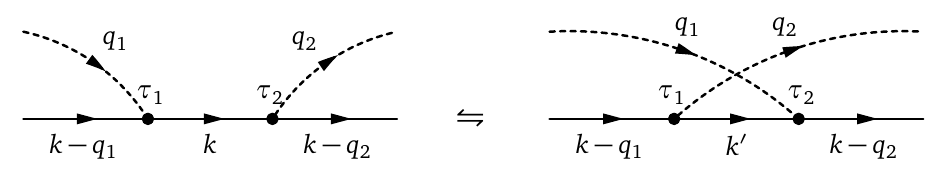
Figure 7: Illustration of the SWAP update. The phonon propagators carrying momentum q and q are understood to connect back to the fermion line at vertices at times τ 2 respectively. τ and τ may each be either before or after τ A B central fermion propagator carries a momentum k (cid:48) = k − q